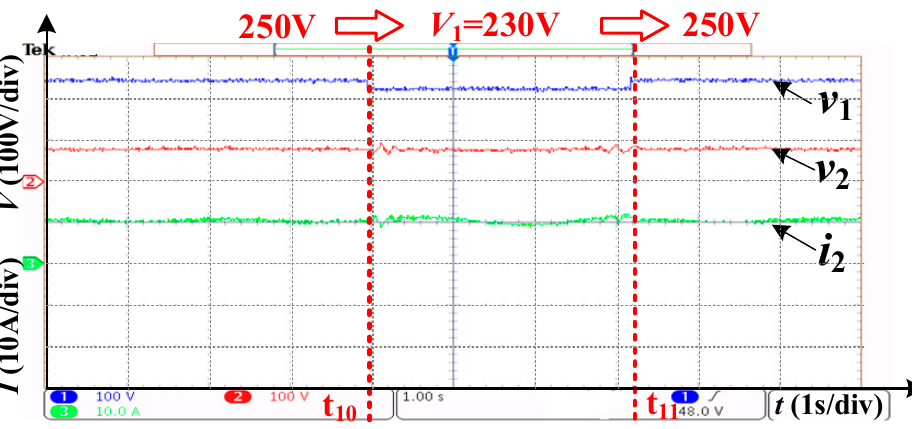
Figure 10. Waveforms in source perturbation experiment.